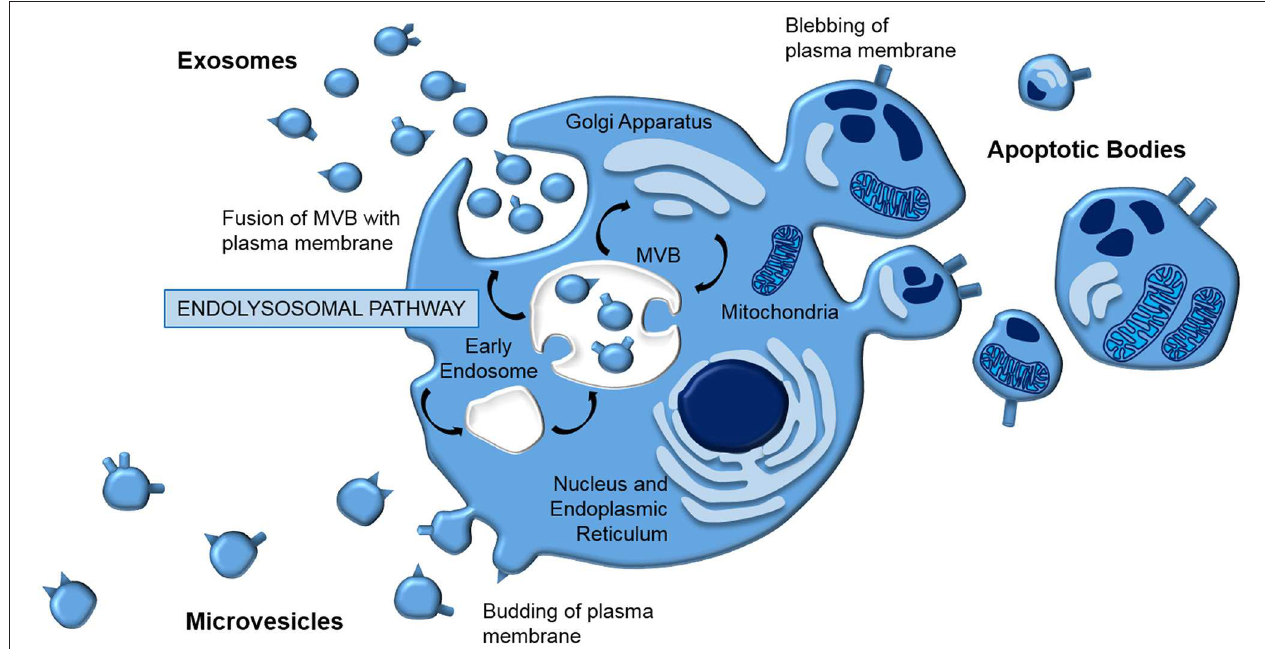
FIGURE 1 | EV biogenesis. EVs are typically classed according to their biogenesis. Apoptotic bodies and microvesicles are released from the plasma membrane in blebbing and budding mechanisms, respectively. In contrast, exosomes are generated by the endolysomal pathway; internal budding of an endosome results in a multivesicular body which fuses with the plasma membrane, releasing exosomes by